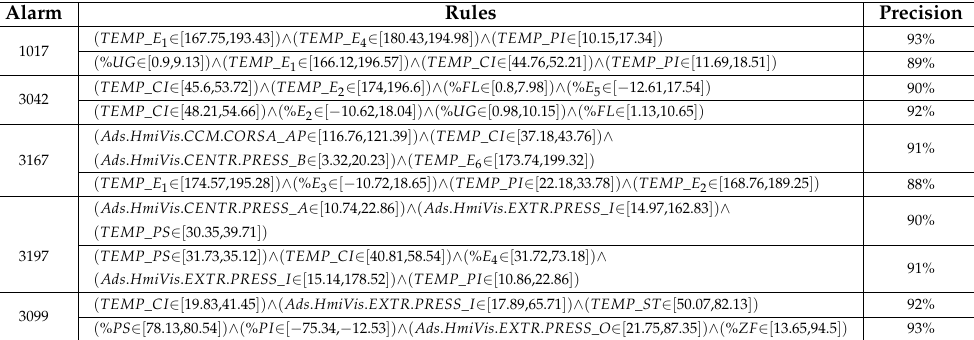
Table 6. Separate-and-Conquer (SeCo) (RUL = 60